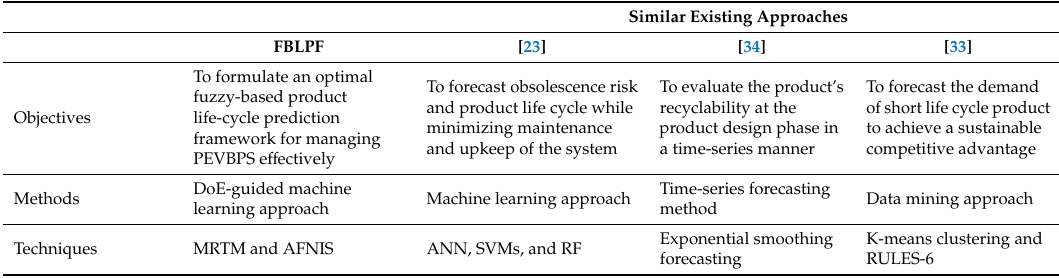
Table 7. Qualitative comparison of the